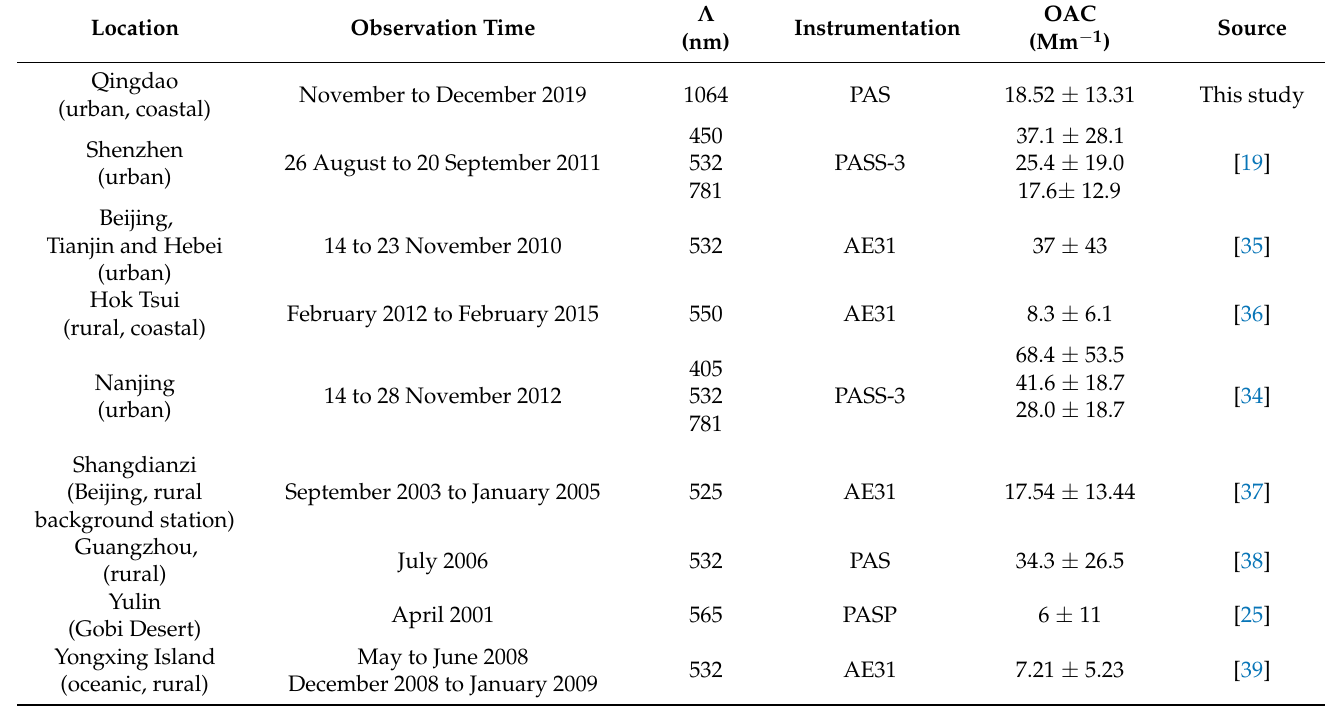
Table 1. Aerosol absorbing coefficients of this and other